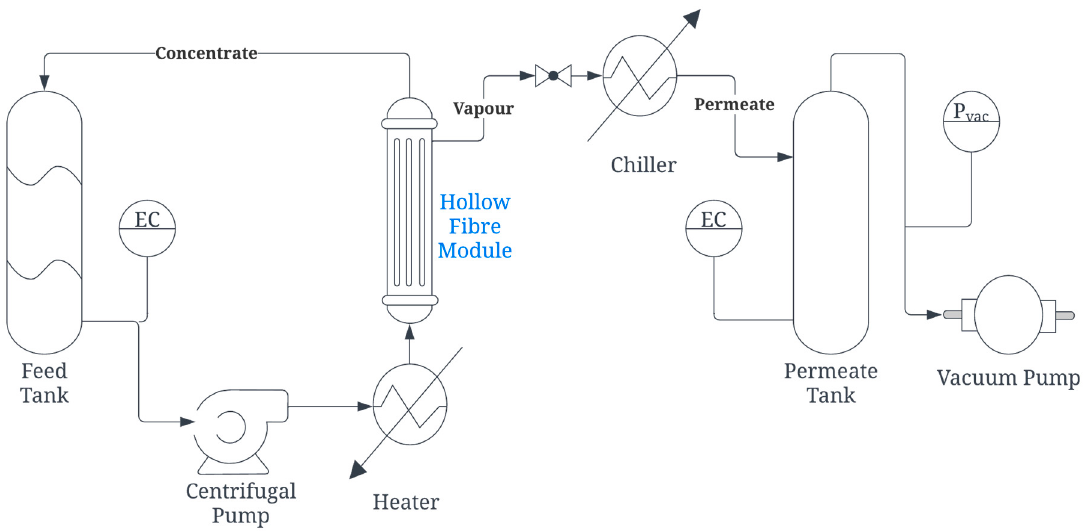
Figure 2. Process flow schematic for the vacuum membrane distillation (VMD) used for testing 2-inch modules at START.